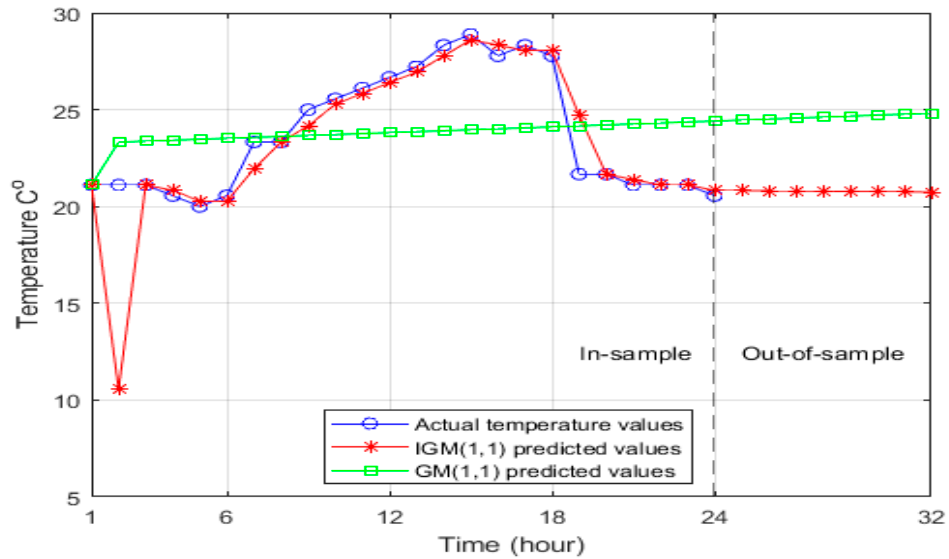
Figure 3. The actual temperature values, the simulation (in-sample), and the prediction (out-of-sam- ple) results of Oakland University’s GHPS output temperature for the next eight hours using both the IGM (1,1) and GM (1,1) models.